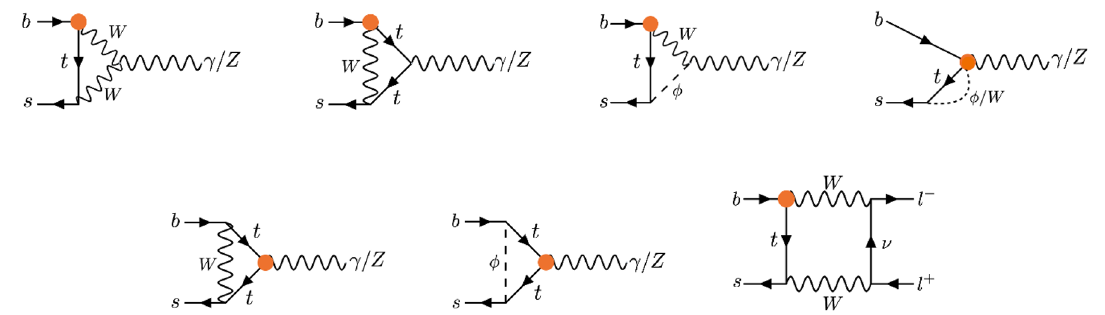
Figure 8. Diagrams generating contributions to b → sl + l − and/or b → sγ from the Q uW and Q uB (3rd and 4th diagrams only) operators. Diagrams in which the operator attaches to the b quark leg imply also the existence (and inclusion in our calculations) of similar diagrams with the operator attached to the s quark